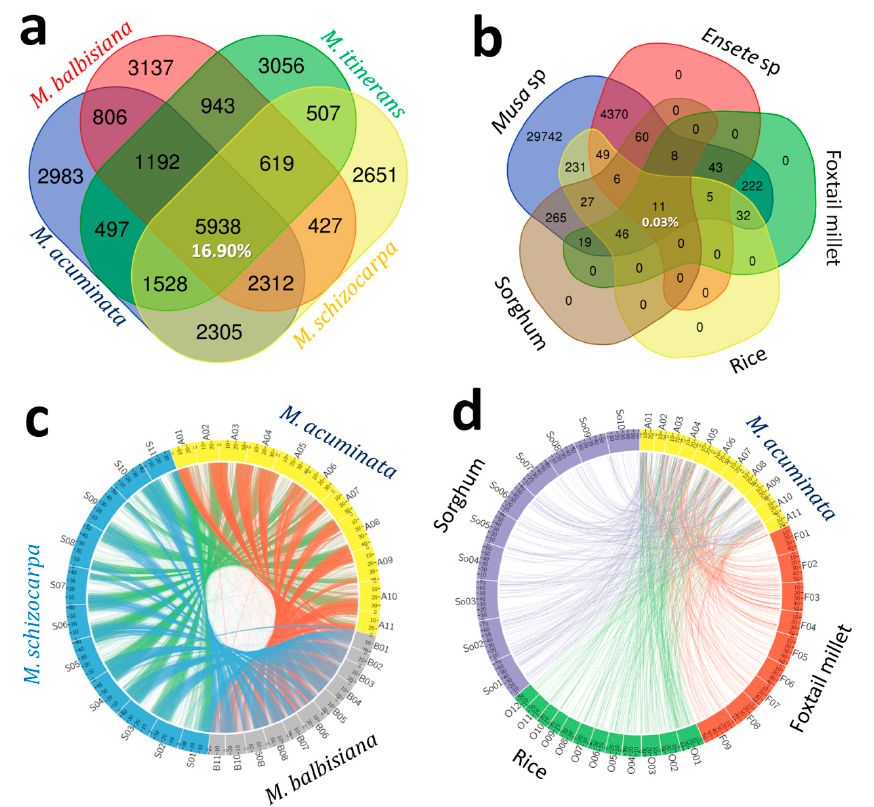
Figure 2. Functionally related microsatellite marker-based genomic relationships of Musa with other plant species. ( a ) Venn diagram representing the common FRSM markers among the three Musa genomes. ( b ) Venn diagram representing the common (transferable) FRSM markers among the Musa and non-musa genomes. ( c ) FRSM-based syntenic relationship among the three Musa genomes. ( d ) FRSM-based syntenic relationship among the Musa and non- Musa genomes. Table 3. A summary of functionally related microsatellite marker-based comparative mapping showing maximum syntenic relationships of the chromosomes of M. acuminata with those of foxtail millet, rice and sorghum.